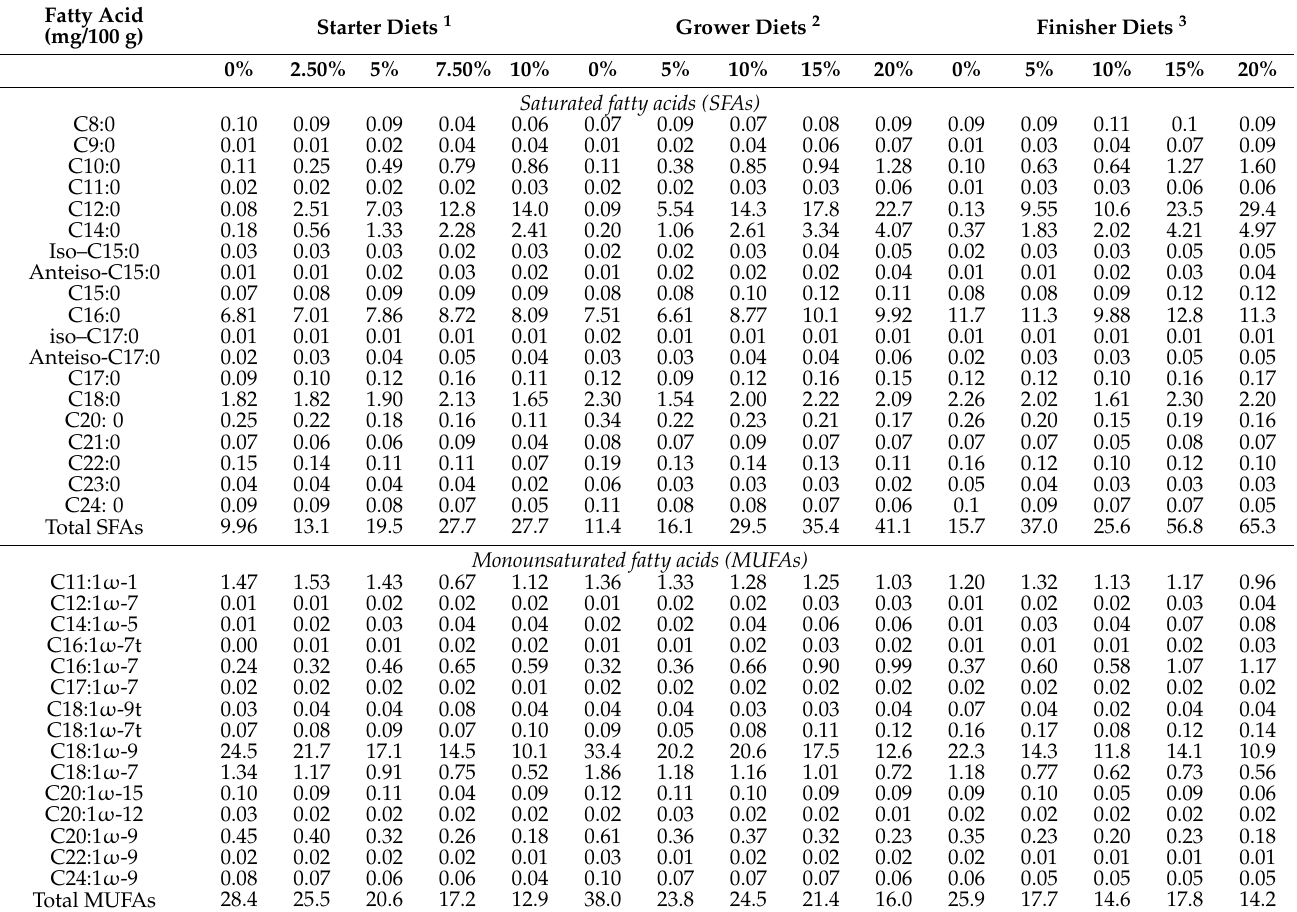
Table 1. Fatty acid profile of experimental diets provided to the broilers at the starter, grower, and finisher dietary phases. Fatty Acid 1 Grower Diets 2 Finisher Diets (mg/100 g) Starter Diets